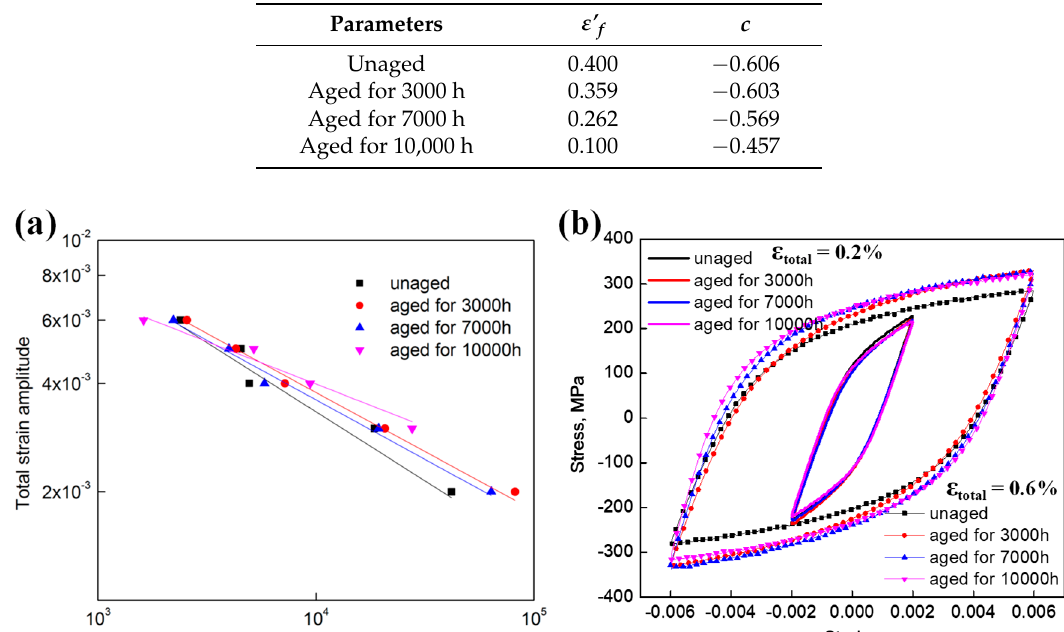
Figure 3. ( a ) Variation of fatigue life of the unaged and aged CDSS with strain amplitude. ( b ) Stable hysteresis loops under 0.2 and 0.6% strain amplitude of specimens with different aging states.